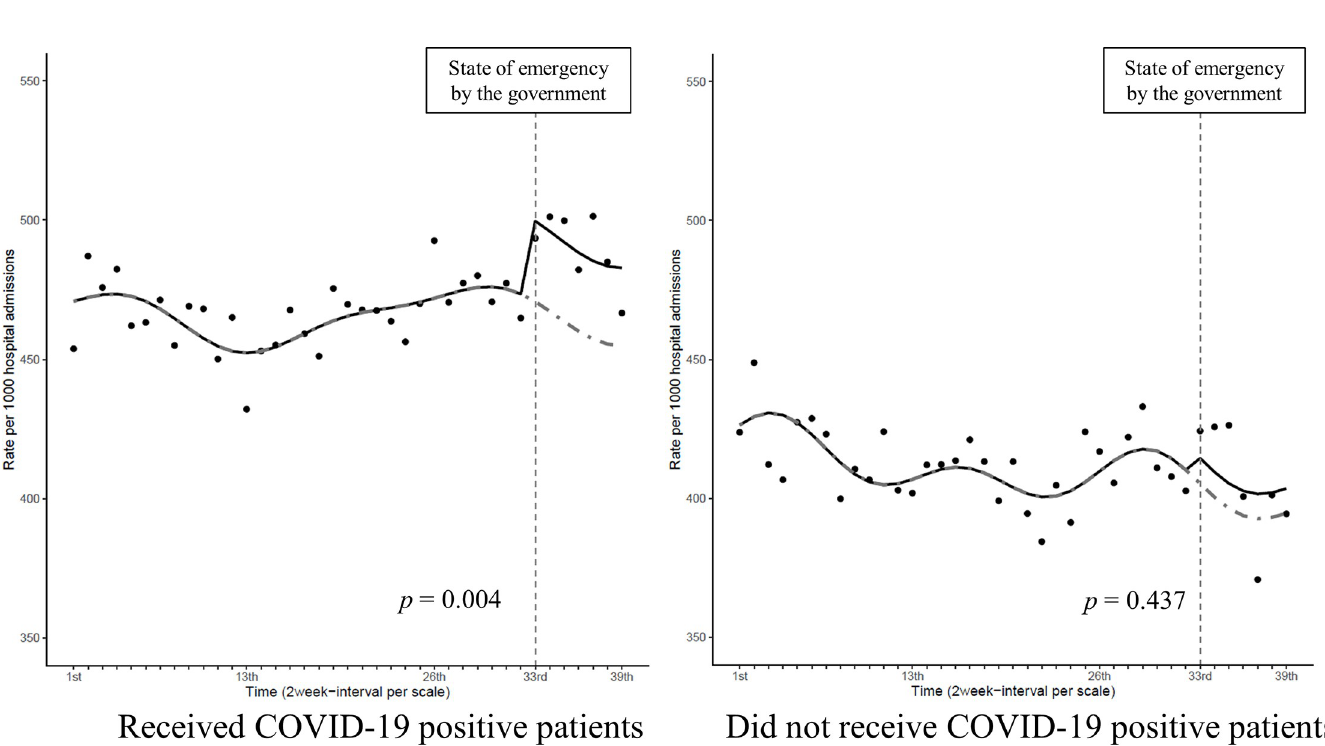
Fig 3. Interrupted time-series analysis of the number of patients who were restrained. The number of patients physically restrained per 1,000 hospital admissions over time was evaluated with an interrupted time-series analysis including segmented regressions (Group 1: p = 0.032; Group 2: p = 0.341). The solid line represents the actual transition and the dotted line represents the hypothetical transition in the absence of